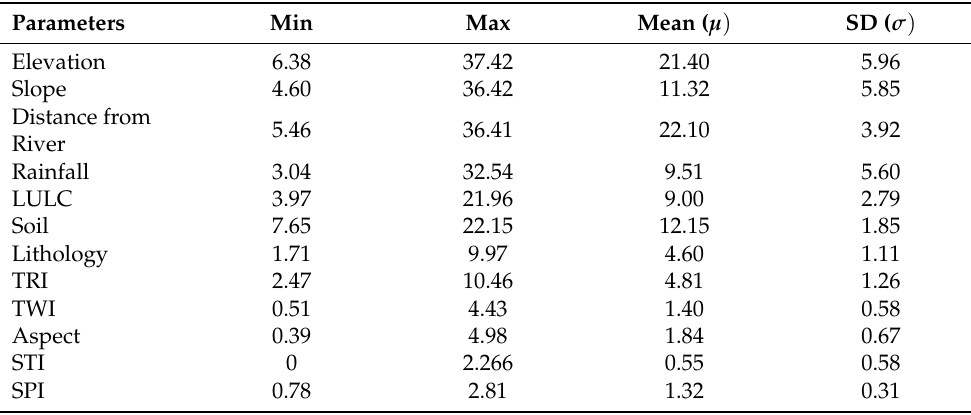
Table 4. Effective weights-sensitivity analysis